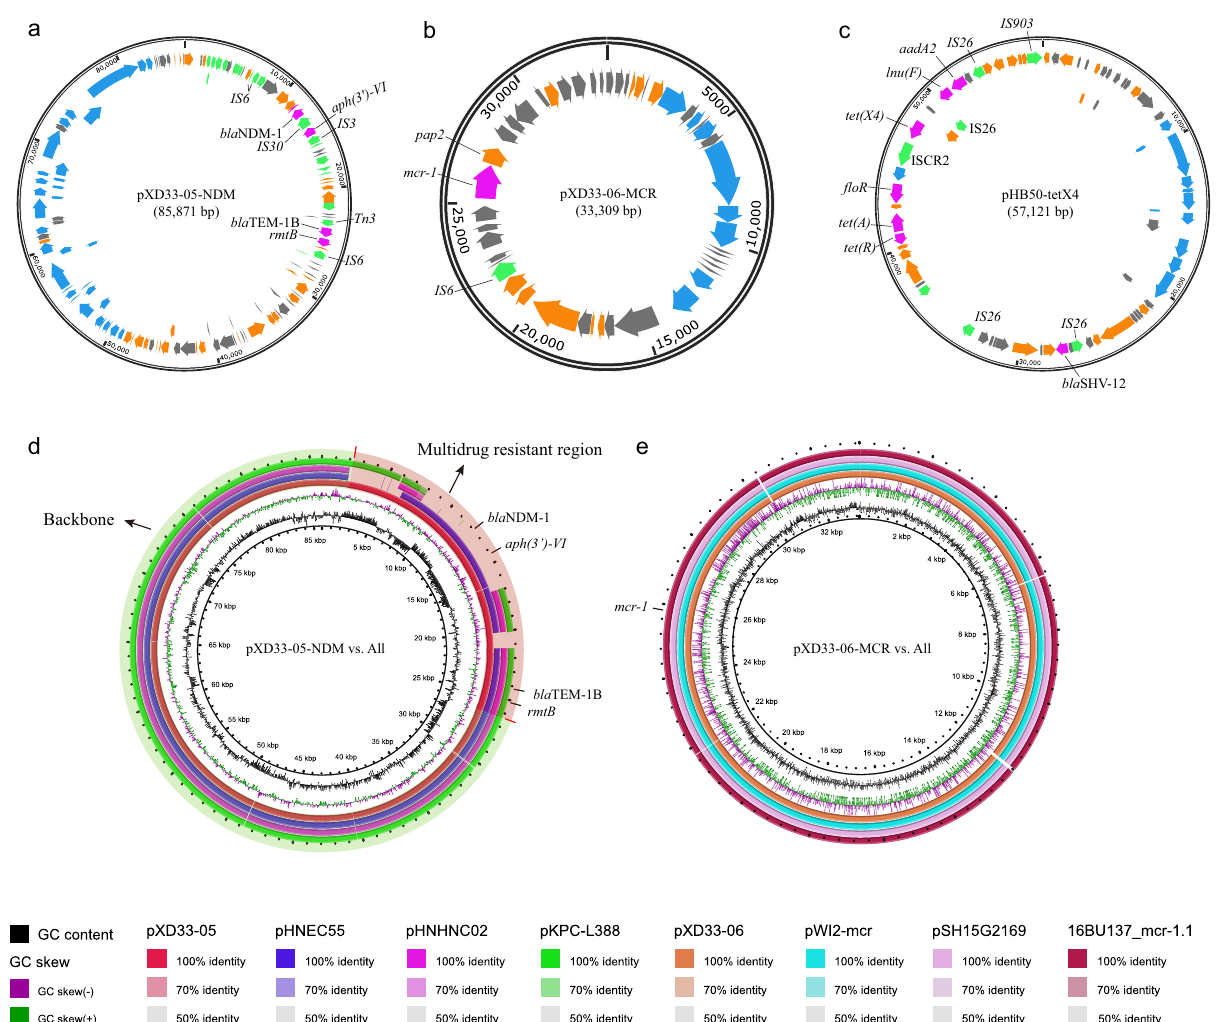
Fig. 4 Genetic characteristics of the bla NDM -carrying, mcr -carrying, and/or tetX4- carrying plasmids identi fi ed in this study. a Circle map showing the structure of the bla NDM -carrying plasmid pXD33-05; b Circle map showing the structure of the mcr -carrying plasmid pXD33-06; c Circle map showing the structure of the tetX4 -carrying plasmid pHB50-tetX4; arrows in purple, green, gray, orange, and blue refer to antimicrobial resistance genes, mobilization- associated genes (including insertion elements), hypothetical protein-encoding genes, functional protein-encoding genes, and type IV pilus formation- related genes, respectively; d Circle map showing sequence alignments of pXD33-05 and those plasmids with a backbone shared with other Enterobacteriaceae bacteria; circles from inside to outside indicate the GC content of pXD33-05 ( circle 1 ), the GC skew of pXD33-05 ( circle 2 ), pXD33-05 ( circle 3 ), the E. coli plasmid pHNEC55 (GenBank accession no. KT879914; circle 4 ), the E. coli plasmid pHNHNC02 (GenBank accession no. MG197497; circle 5 ), and the K. pneumoniae plasmid pKPC-L388 (GenBank accession no. CP029225; circle 6 ); the plasmid backbone regions are highlighted in light green, while the multidrug resistance regions are highlighted in light red; nucleotide identities are shown with different colors below the maps; e Circle map showing the sequence alignments of pXD33-06 and those plasmids with a backbone shared with other Enterobacteriaceae bacteria; circles from inside to outside indicate the GC content of pXD33-06 ( circle 1 ), the GC skew of pXD33-06 ( circle 2 ), pXD33-06 ( circle 3 ), the E. coli plasmid pWI2-mcr (GenBank accession no. LT838201; circle 4 ), the Salmonella plasmid pSH15G2169 (GenBank accession no. MH522417; circle 5 ), and the K. pneumoniae